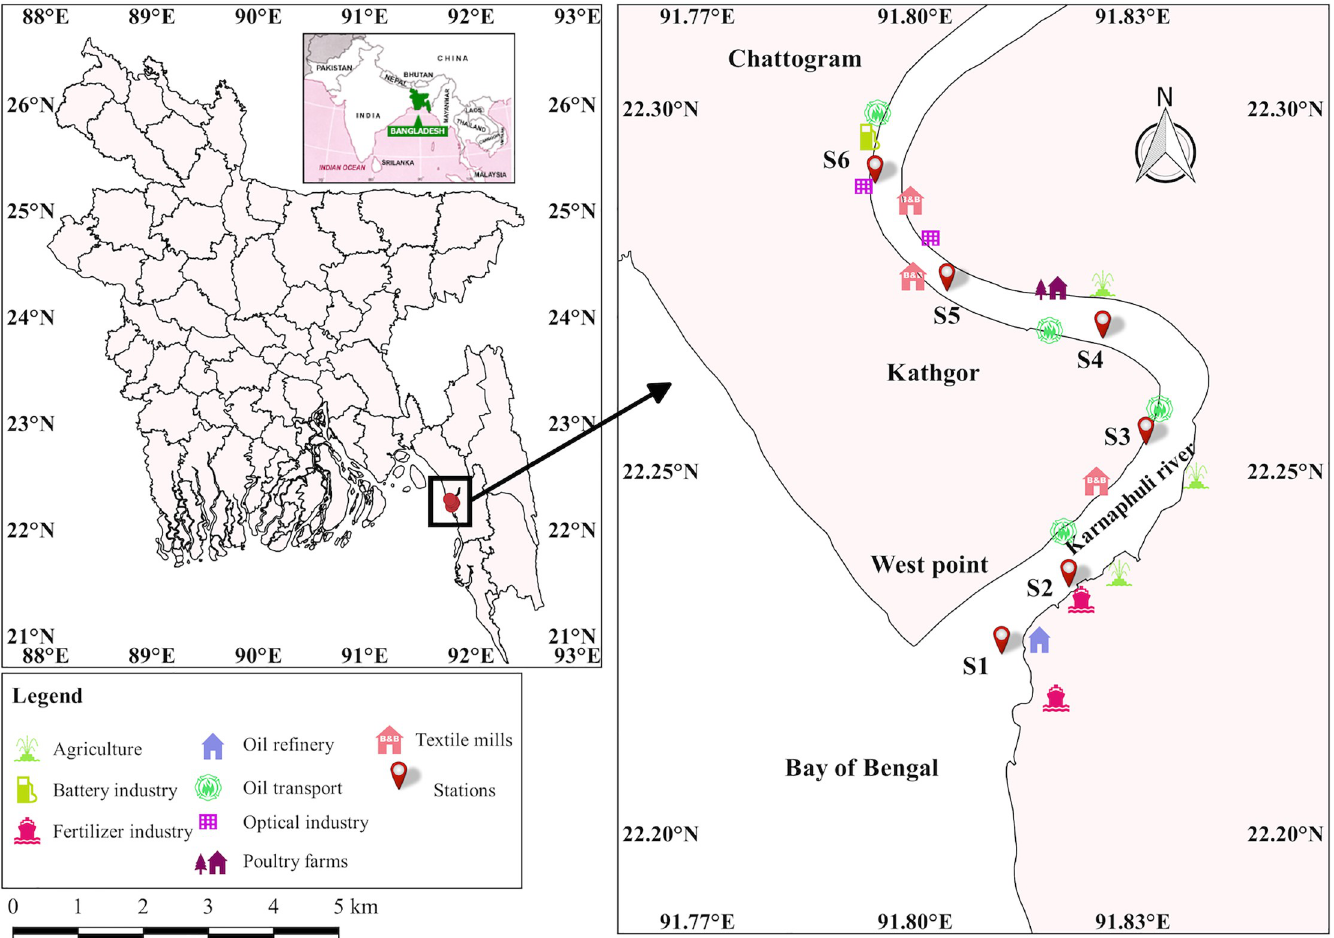
Fig 1. Six sampling locations in Karnaphuli River estuary and the source of heavy metal pollution. [Reprinted from (www.wikipedia.org) under a CC BY license, with permission from (Wikipedia), original copyright (2007)]. https://doi.org/10.1371/journal.pone.0219336.g001 PLOS ONE | https://doi.org/10.1371/journal.pone.0219336 October 17,